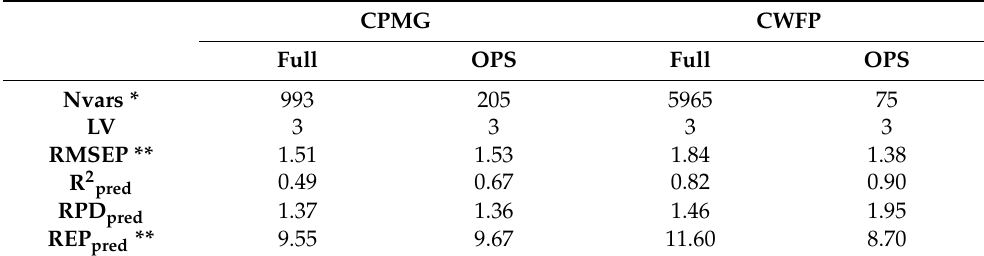
Table 1. Performance parameters of the PLS models obtained using all variables and those selected by the OPS algorithm for DDM quantification.